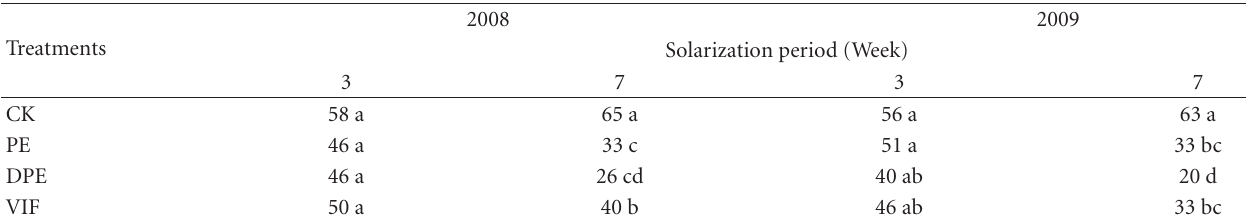
Table 3: E ff ect of solarization with regular polyethylene (PE), double regular polyethylene (DPE), and virtually impermeable films (VIF)